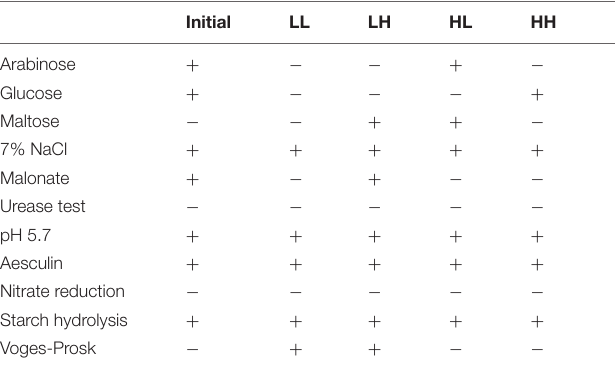
TABLE 1 | Physiological and biochemical characteristics of B. pumilus under warming and acidification